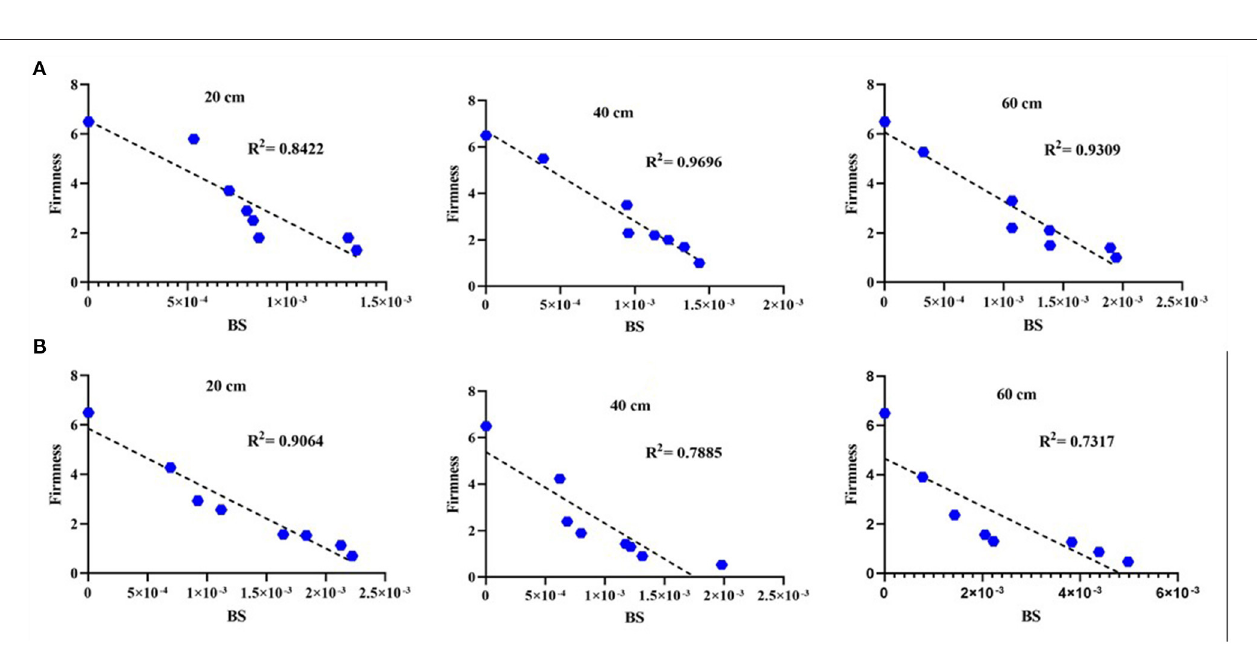
FIGURE 11 | Single linear regression between BS and firmness at different drop heights (20, 40, and 60cm) during 14 days at (A) 10 ◦ C and (B) 22 ◦ C storage conditions.